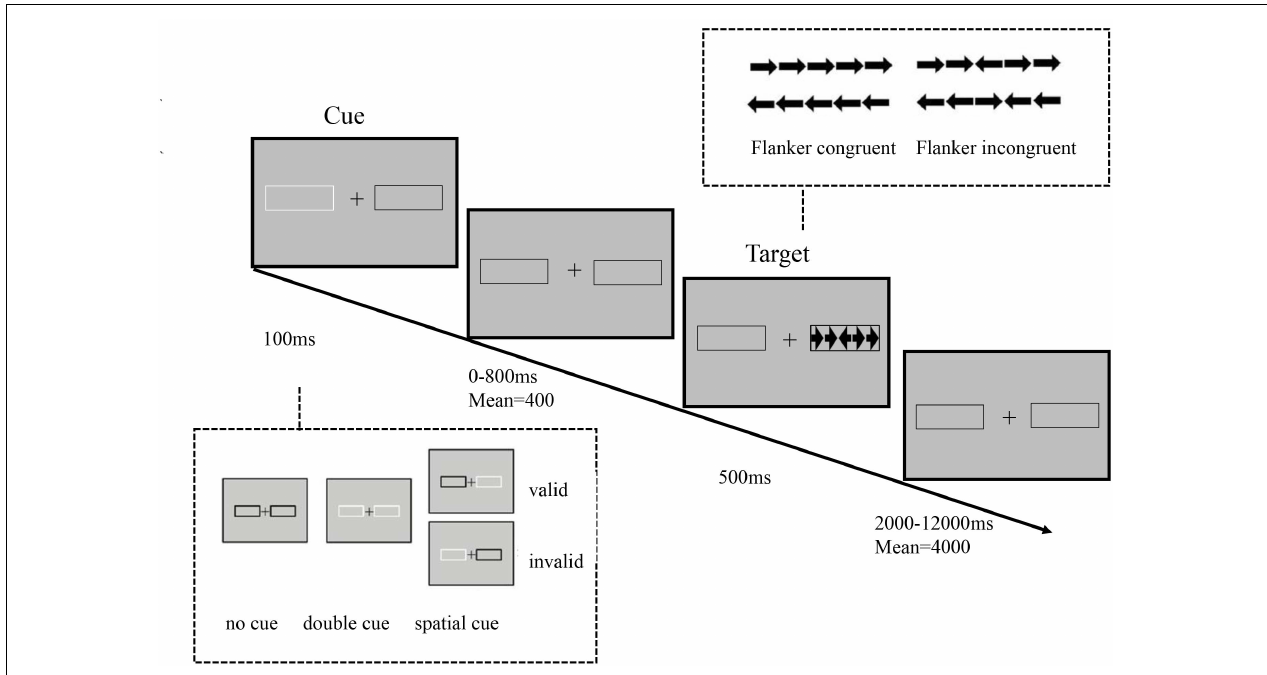
FIGURE 1 | Schematic of the visual attention network task